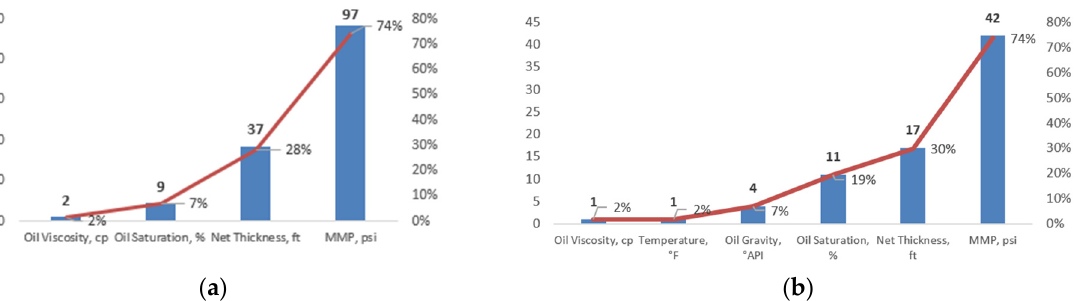
Figure 4. Amount of missing data: ( a ) miscible CO 2 -EOR, ( b ) immiscible CO 2 -EOR.